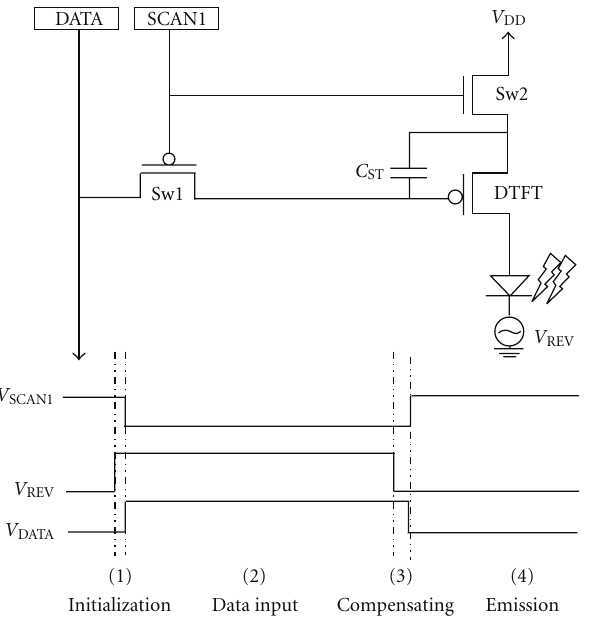
Figure 1: New pixel design circuit and its timing diagram.